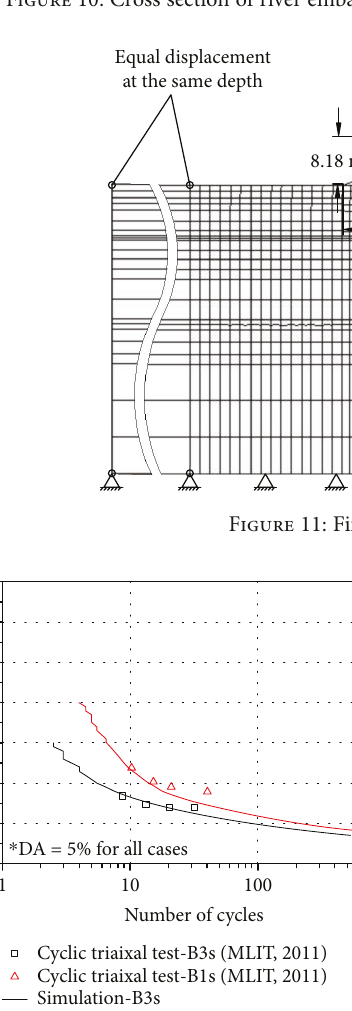
Figure 10: Cross section of river embankment at Shimonakanome upper stream of Naruse River (30.3km).